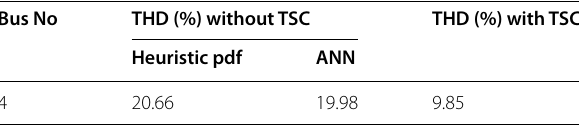
Table 19 THD of real power flow with and without TSC for IEEE 9 -bus system at bus